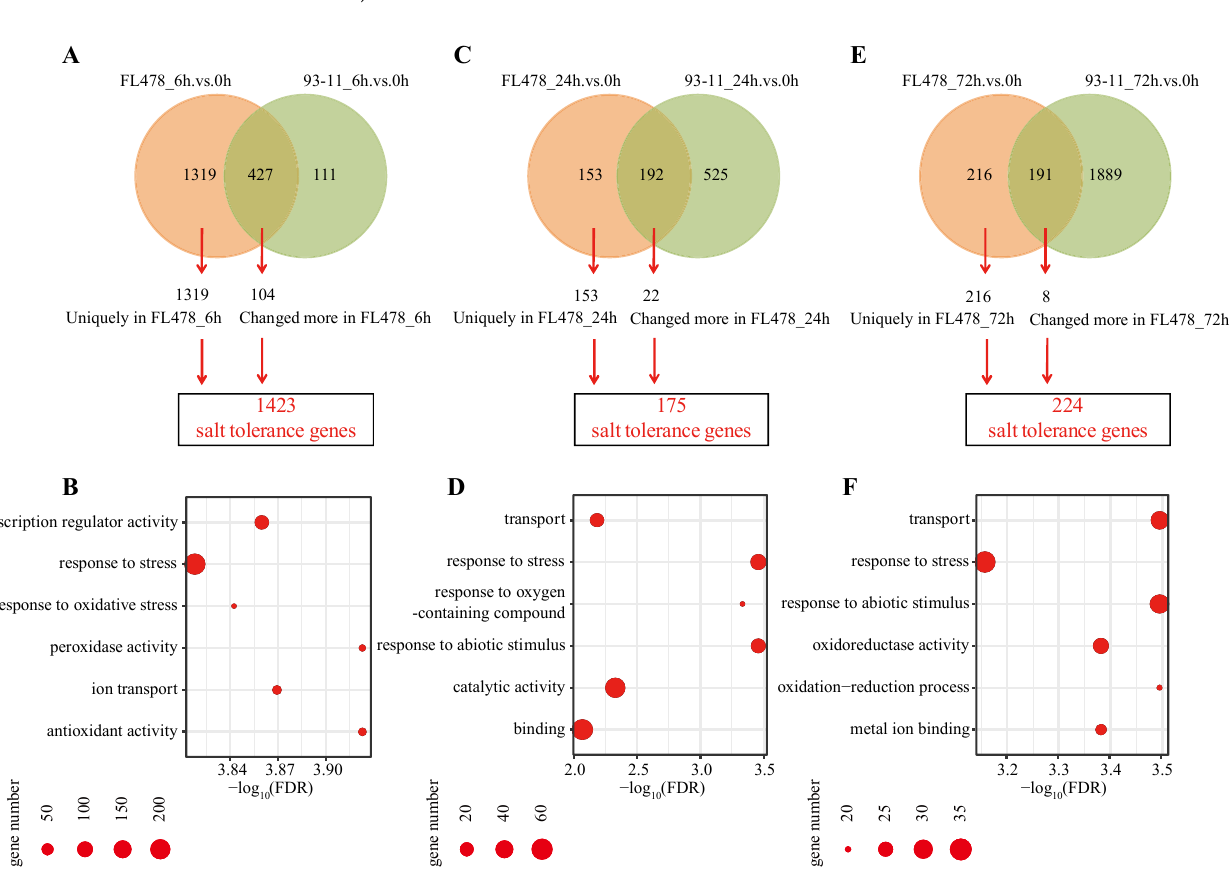
Figure 2. The salt-tolerance genes identified in FL478 relative to 93-11. ( A , C , E ) Venn diagrams of DEGs identified at 6 h, 24 h, and 72 h, respectively. The salt tolerance genes were defined as those DEGs specifically regulated or more (i.e., >two-fold) changed in FL478 relative to 93-11. ( B , D , F ) GO enrichment of salt tolerance genes at 6 h, 24 h, and 72 h after salt treatment.